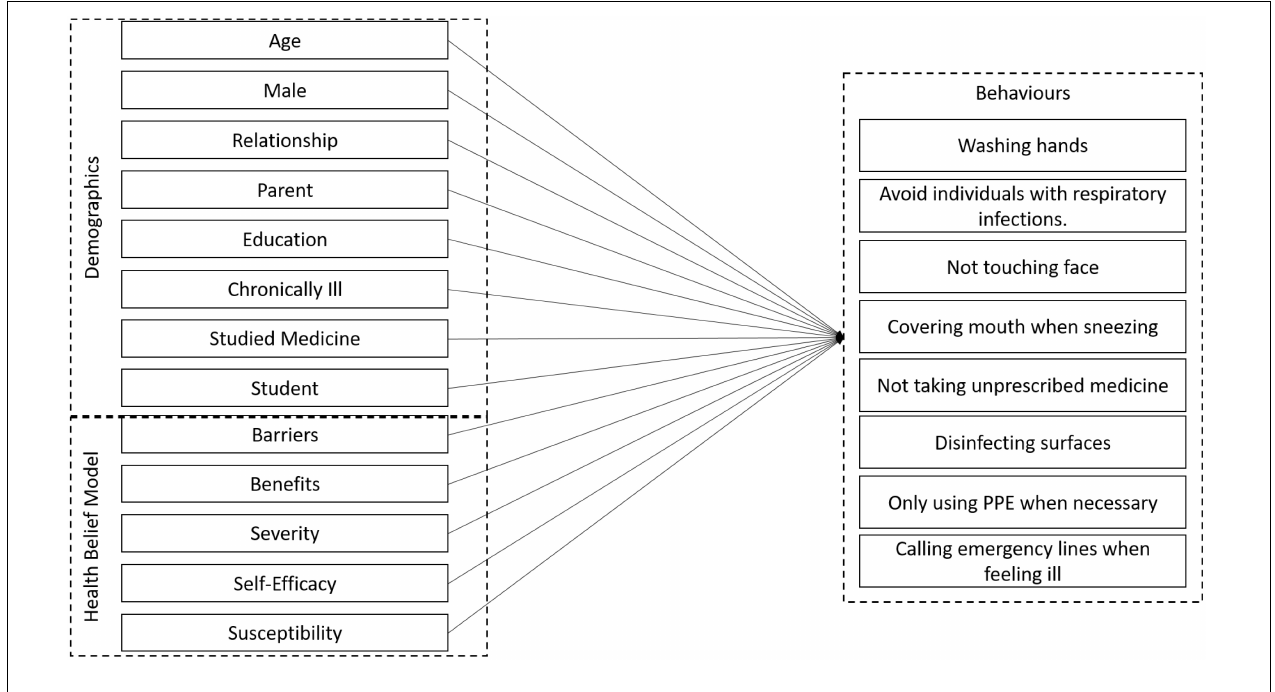
FIGURE 3 | Conceptual representation of the path-model with all behaviors entered